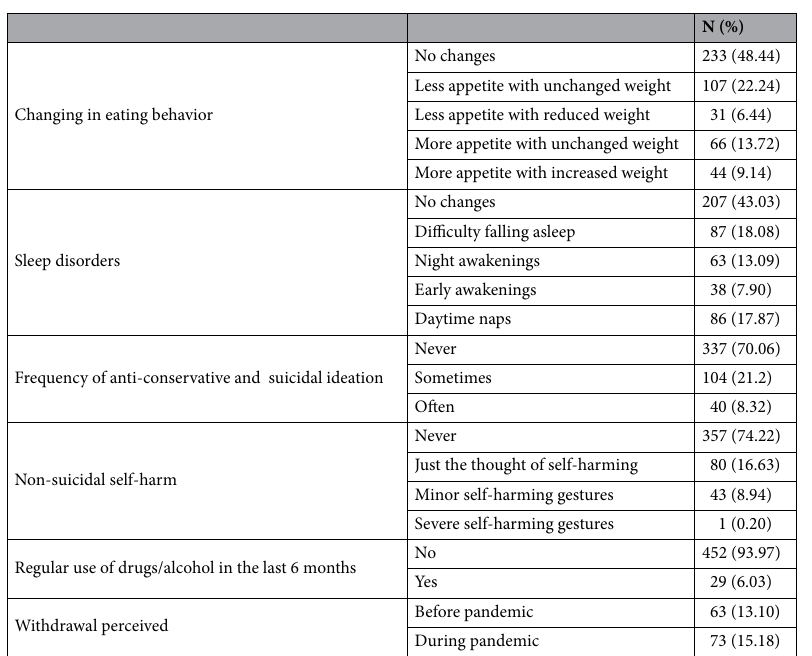
Table 3. Prevalence rate of dysfunctional eating behaviors, sleep problems, substances abuse, and social